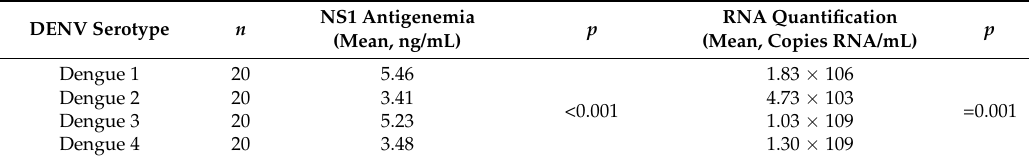
Table 1. Overall NS1 antigenemia and RNA viral load according to the distinct DENV serotypes, independent of the disease outcome.